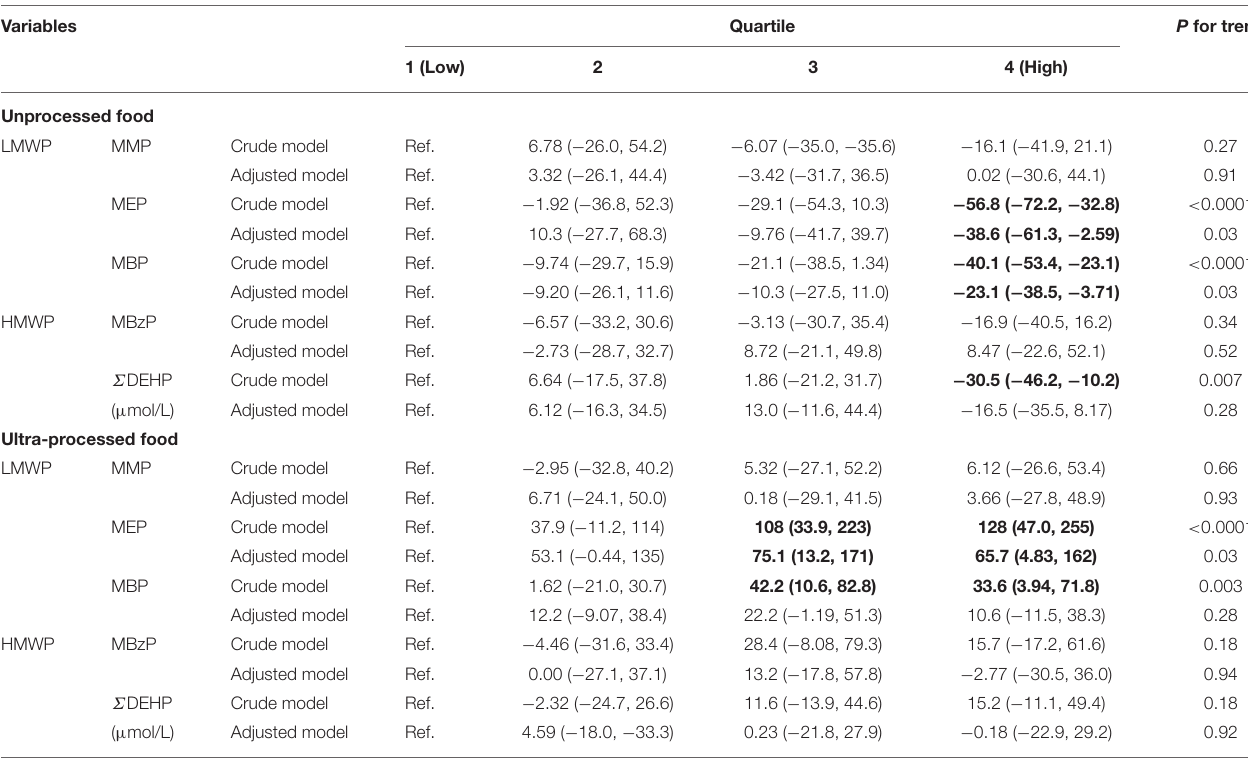
TABLE 3 | Percentage difference (95% confidence interval) in urinary phthalate metabolites ( µ g/L) by quartiles of unprocessed and ultra-processed food intake ( n = 516).